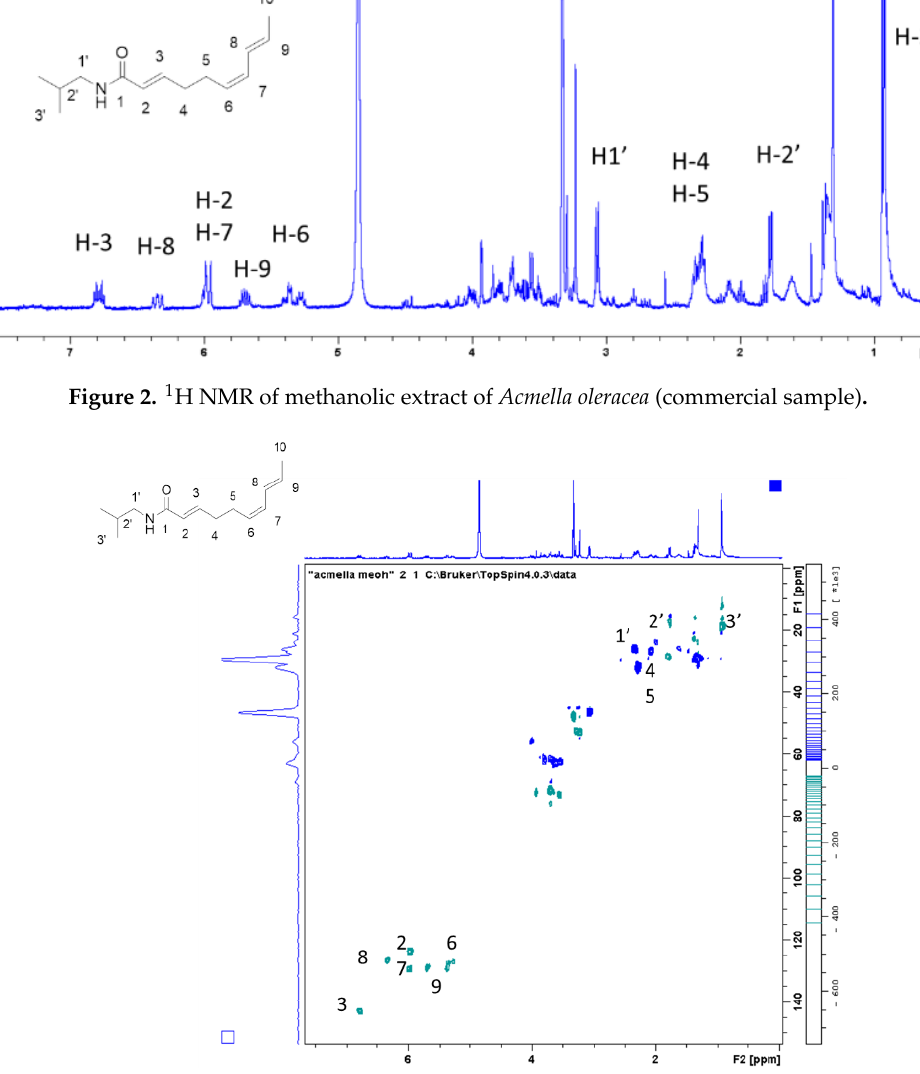
Figure 3. Spilanthol assignment in the HSQC-DEPT spectrum in extract obtained from reference plant material.